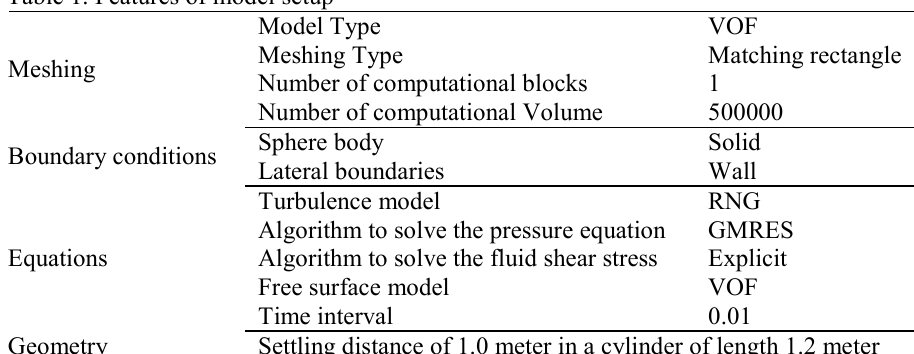
Table 1. Features of model setup Meshing